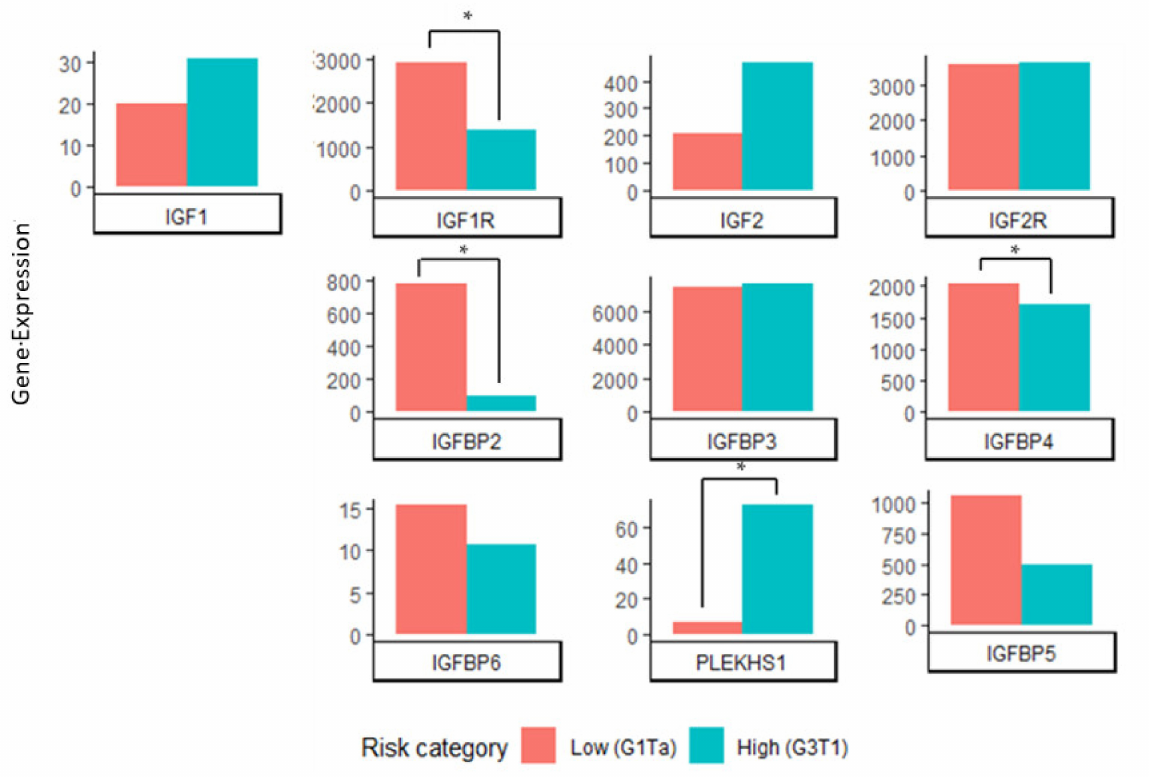
Figure 4. mRNA expression of the PLEKHS1 gene is significantly increased in G3T1 tumours compared to G1Ta. IGFBP2, IGFBP4, and IGF1R are significantly decreased in G3T1 compared to G1Ta tumours. Different Y -axes were used for each gene to improve the data visualisation. (* p =